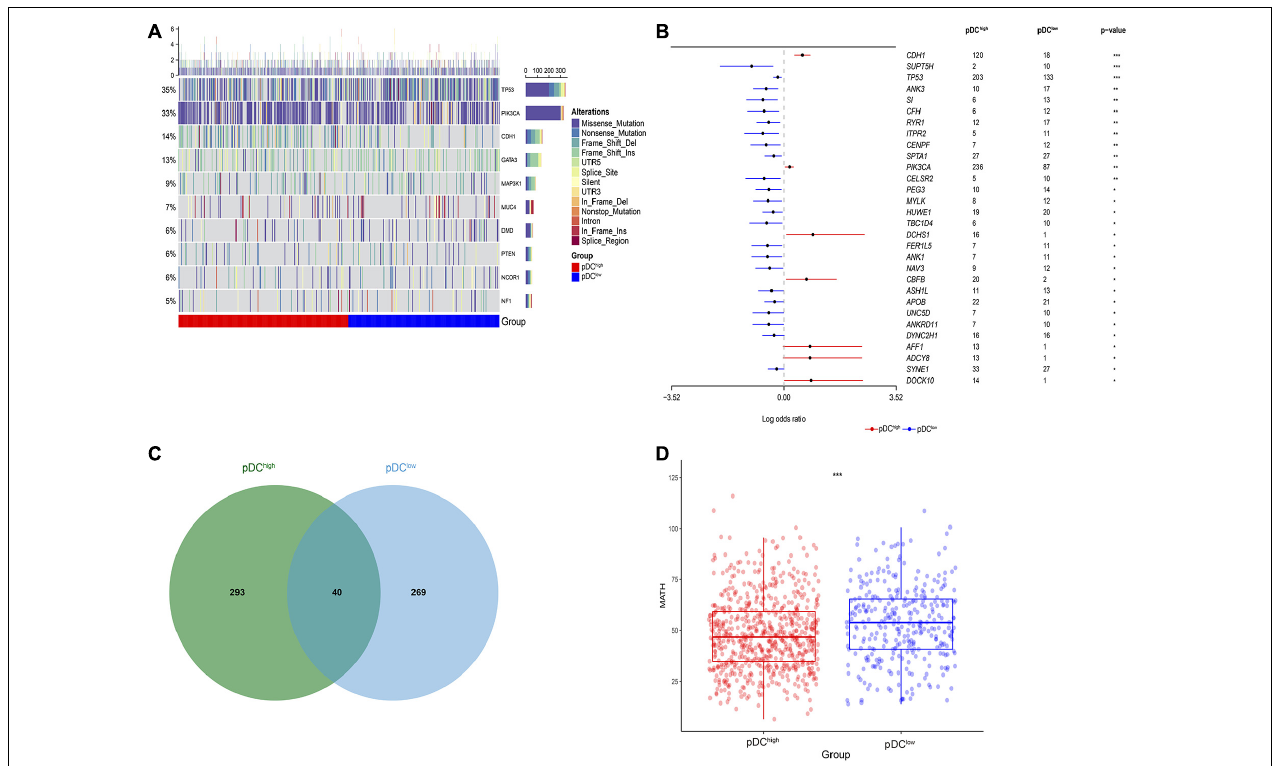
FIGURE 6 | Genetic alteration across the pDC groups. (A) Somatic mutation landscape of significantly mutated genes in TCGA. (B) Differentially mutated genes between the pDC high group and the pDC low group. (C) Shared significantly mutated genes between the pDC high group and the pDC low group. (D) Boxplot of intratumoral heterogeneity between the two groups. The meaning of the statistical difference is as follows: * represents p ≤ 0.05, ** represents p ≤ 0.01, and *** represents p ≤ 0.001.